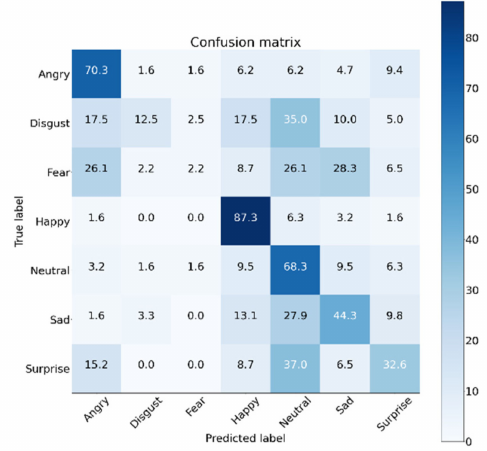
Figure 8. Confusion matrix of C3D-GRU for the AFEW dataset.